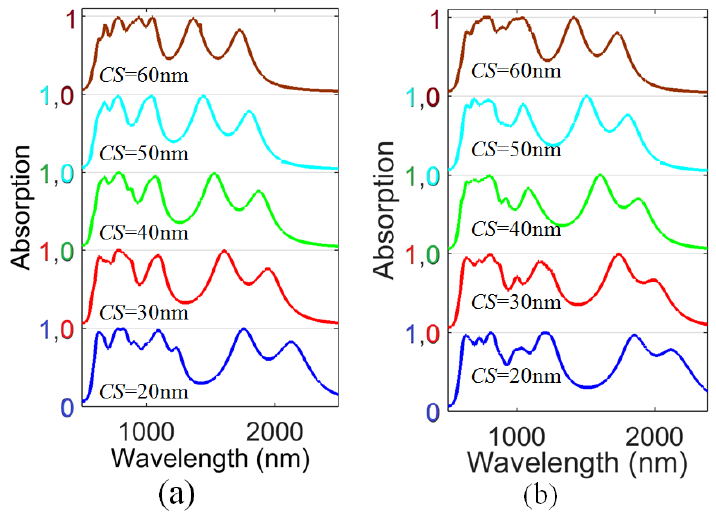
Figure 3. Absorption spectra for different combine split ( CS ) sizes at ( a ) r = 80 nm, and ( b ) r = 90 nm.